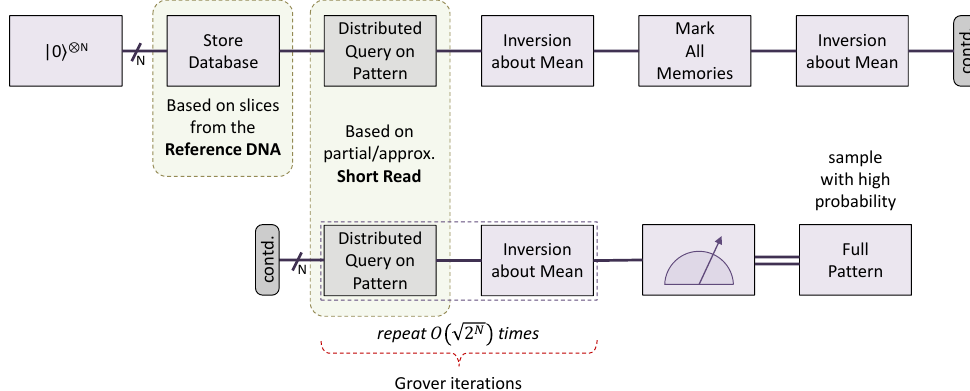
Figure 4. Quantum associative search algorithm with distributed query.